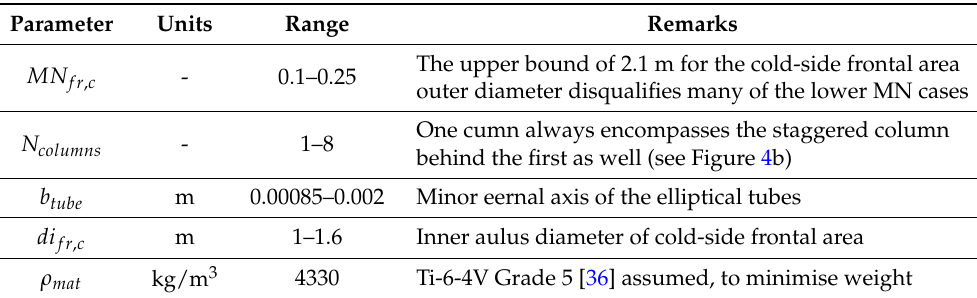
Table 6. Pre-Cooler design